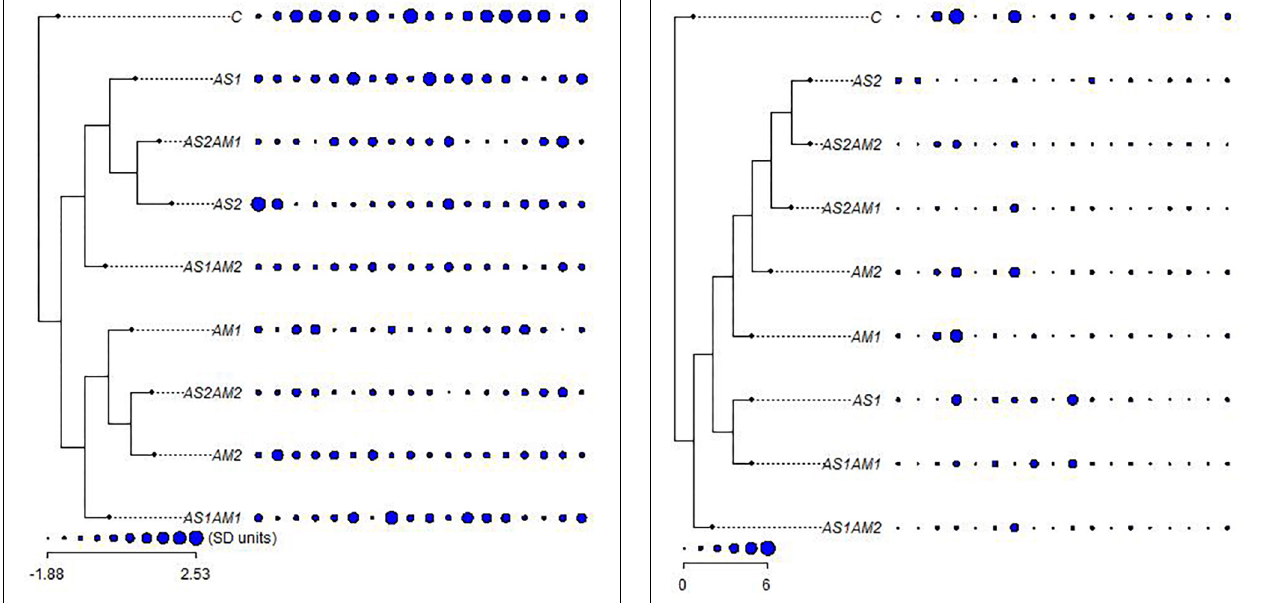
FIGURE 3 | The relationships between arsenic-treated groups of fishes supplemented with Amphora coffeaeformis extract versus the control group with ANOVA-based coded hematological and biochemical characters (ordered as AST, ALT, ALP, GL, TP, AL, GLO, AG, UR, CR, LDH, RBCs, HB, HCT, MCV, MCH, MCHC, and WBCs) (Mesquite and R packages). AS1 (19.2 mg/L arsenic), AS2 (38.3 mg/L arsenic), AM1 (7% Amphora), and AM2 (10%